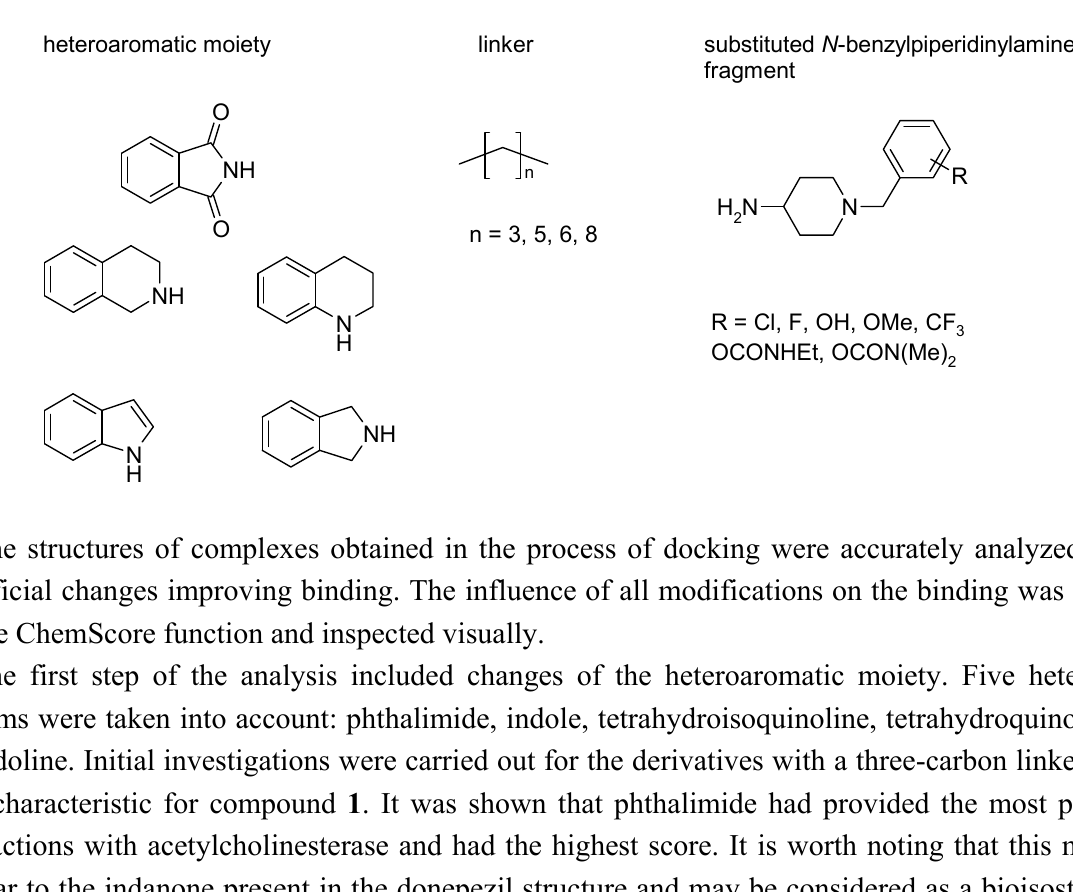
Figure 7. Modifications of heterodimeric compounds 1 and 2